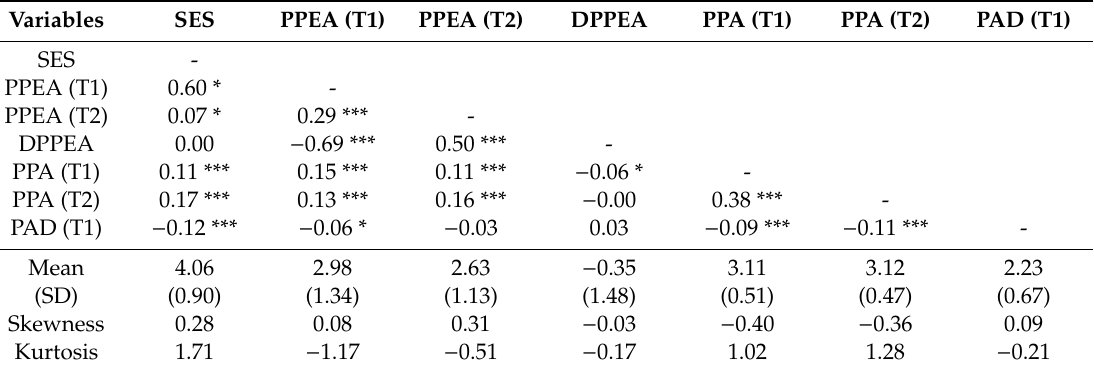
Table 4. Correlation and statistical analyses of observed variables for Cohort 4.